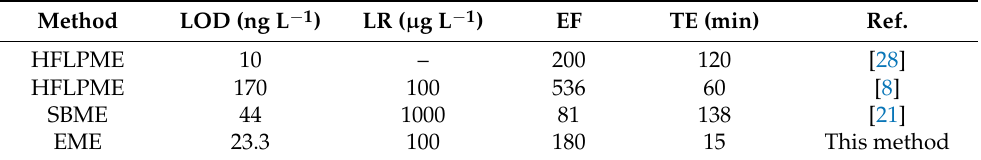
Table 1. Comparison of operational conditions of the proposed method and other liquid micro- extraction methods for determination of Ni in